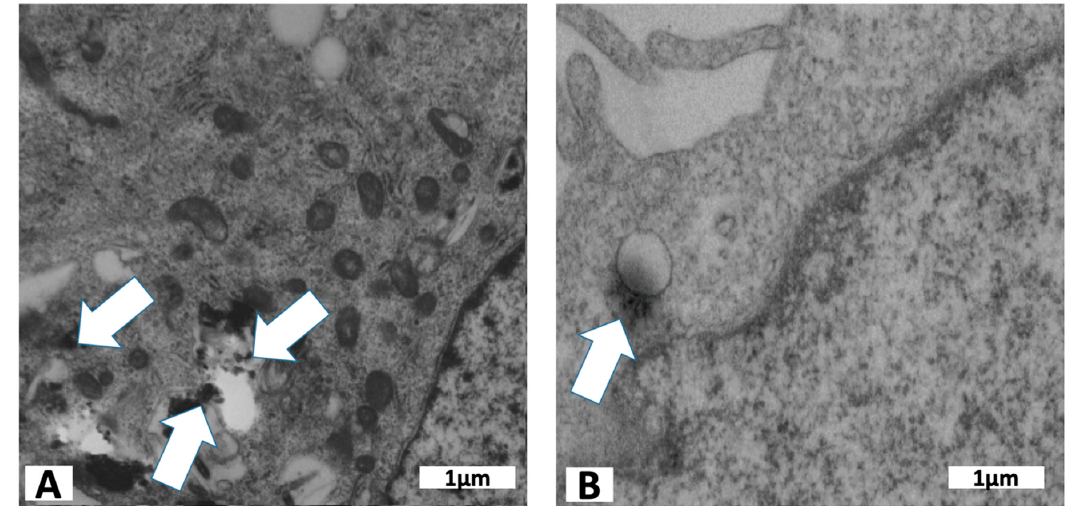
Figure 4. ZnO-NP disposition. TEM analysis of hMSCs cultivated with DMEM-EM ( A ) and plasma ( B ) after ZnO-NP exposure. In both pictures, ZnO-NP can be detected within the cytoplasm.